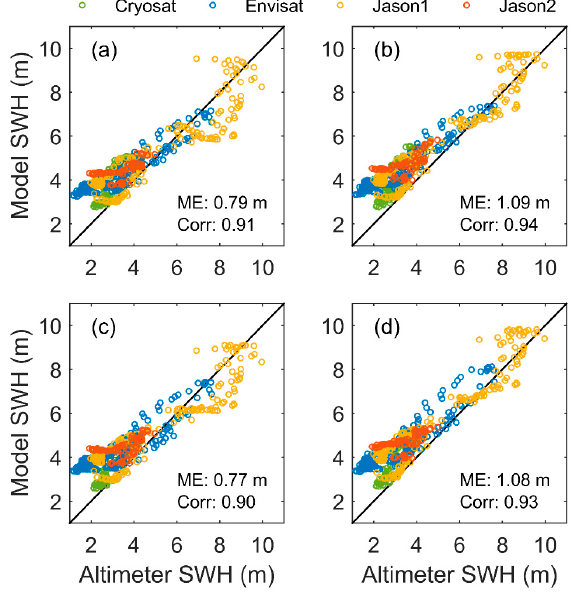
Figure 9. Typhoon Megi. Comparison of altimeter observed SWH with model results from experi- ments ( a ) R0, ( b ) R1, ( c ) R2, and ( d ) R3. See Table 1 for details of the different numerical experiments.